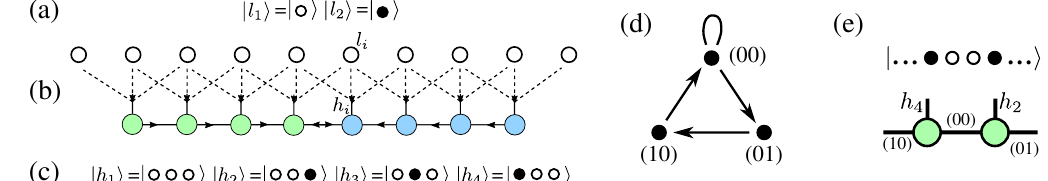
〉 . The open (filled) circle Figure 13: (a) Local Hilbert space of the original model | l i stands for an empty (occupied) site. (b) Rigorous mapping onto a model with a local Hilbert space of the MPS (blue and green tensors) spanned over three consecutive sites (empty circles) that consist of four states sketched in (c). These four states form physical bond (vertical lines) of local tensors (blue and green circles), with are contracted with each other via auxiliary bonds (horizontal lines). (d) Fusion graph for the recursive construction of the left environment (green tensors in (b)); for the right environment (blue tensors in (b)) the direction of the arrows should be inverted. (e) Example of the label assignment on two consecutive tensors written for the selected